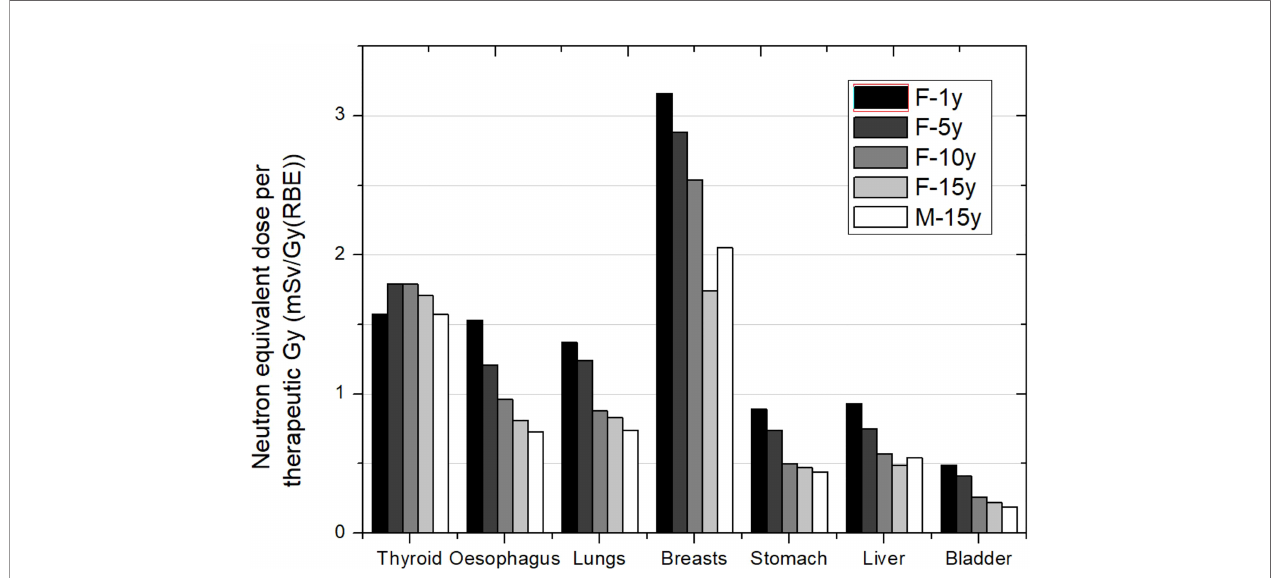
FIGURE 1 | Neutron equivalent doses per therapeutic Gy in selected organs for a brain treatment in the same passive scattering proton beam facility and several patient ages. In the legend, the sex (F, female; M, male) and age of the patient (#y = number of years) are speci fi ed. Data extracted from Sayah et al.